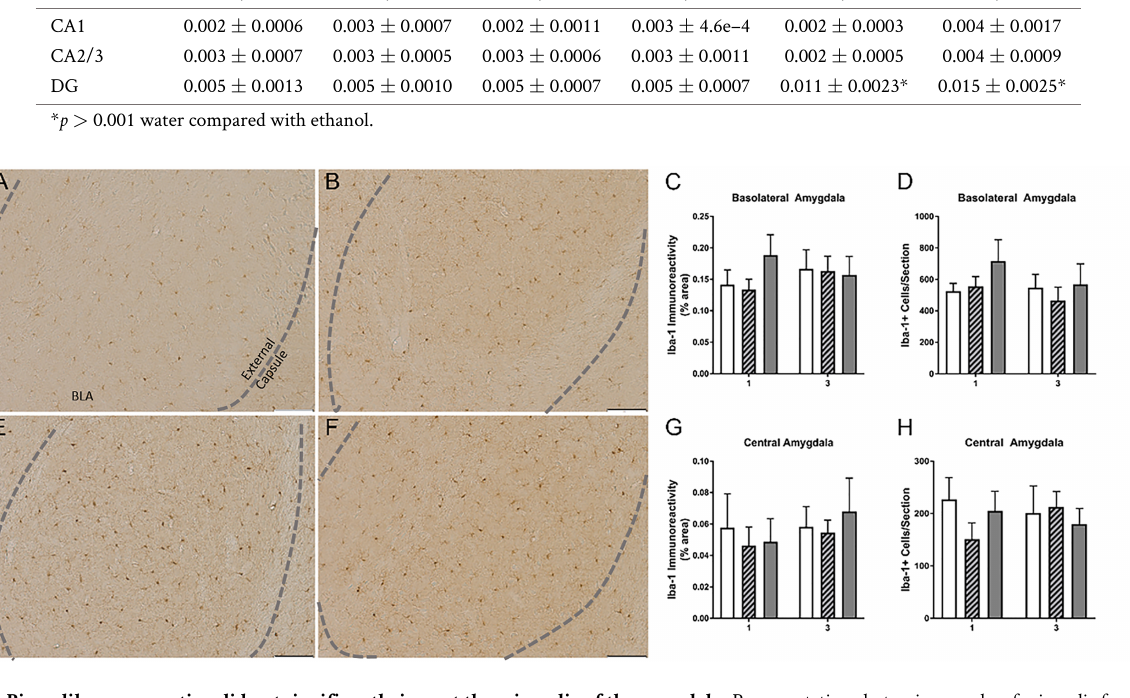
Fig. 3. Binge-like consumption did not significantly impact the microglia of the amygdala. Representative photomicrographs of microglia from the basolateral amygdala (BLA) indicate consistent density and morphology in mice with 3 cycles of water (A), 3 cycles of sucrose (B), 1 cycle of EtOH (E), or 3 cycles EtOH (F). The dashed grey lines outline the ventral boundaries of the external capsule along the BLA. Quantification of the immunoreactivity (IR) indicated that EtOH did not affect the IR in either BLA (C) or the CeA (G). Likewise, no significant differences were observed in the microglia number (D, H). Scale bars in representative photomicrographs = 50 µ